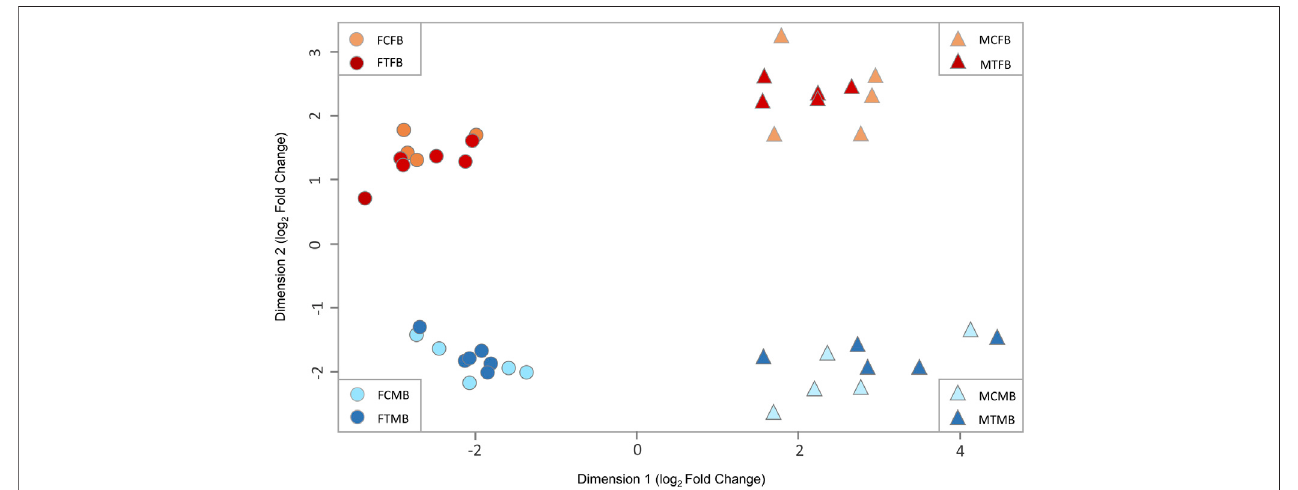
FIGURE 3 | Multidimensional scaling analysis (MDS) of overall DNA methylation pro fi les in zebra fi sh gonad. The fi rst dimension ( x -axis) separates females from males in both sex-biased families. The second dimension ( y -axis) separates female-biased family from male-biased family. FCFB (female control female-biased), FTFB (female treatment female-biased), MCFB (male control female-biased), MTFB (male treatment female-biased), FCMB (female control male-biased), FTMB (female treatment male-biased), MCMB (male control male-biased), MTMB (male treatment